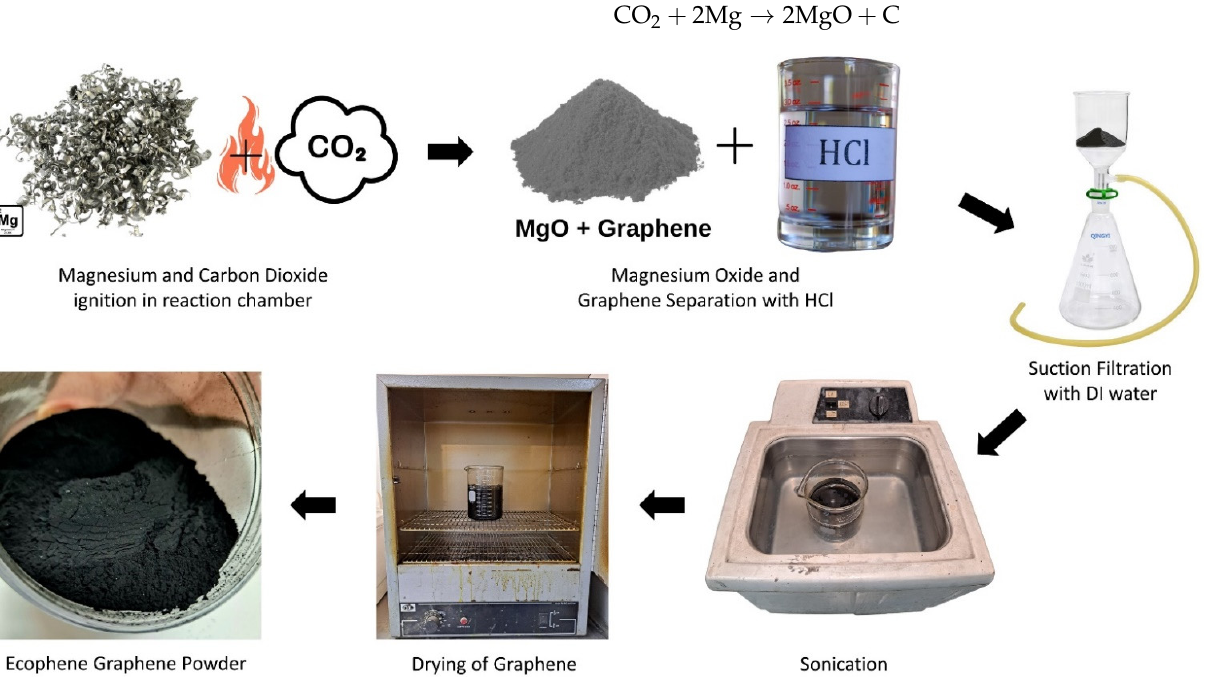
Figure 2. Process steps for sustainable synthesis of multilayer graphene from CO 2 isolated from ambient air.